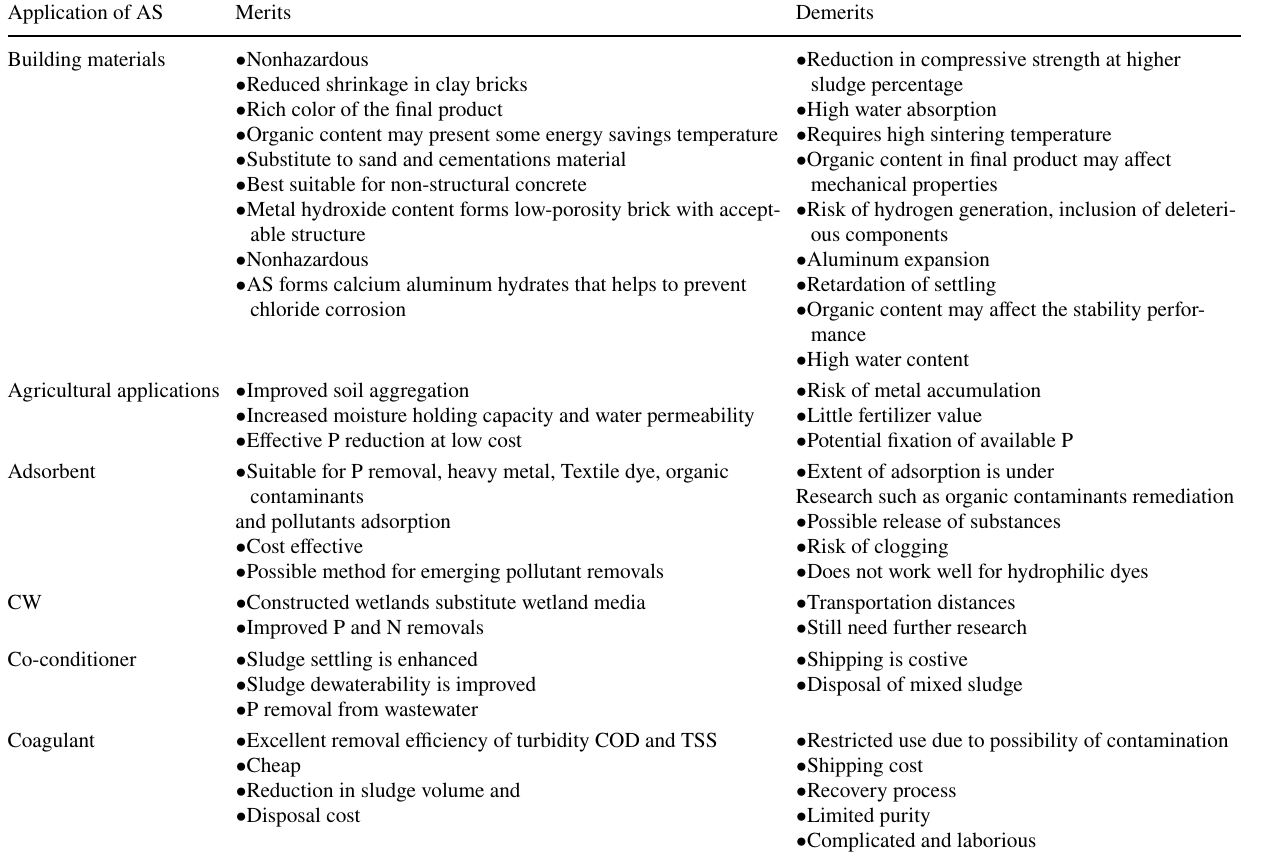
Table 6 Summarized disposal AS alternative of reusing options with their associated merits and impacts*